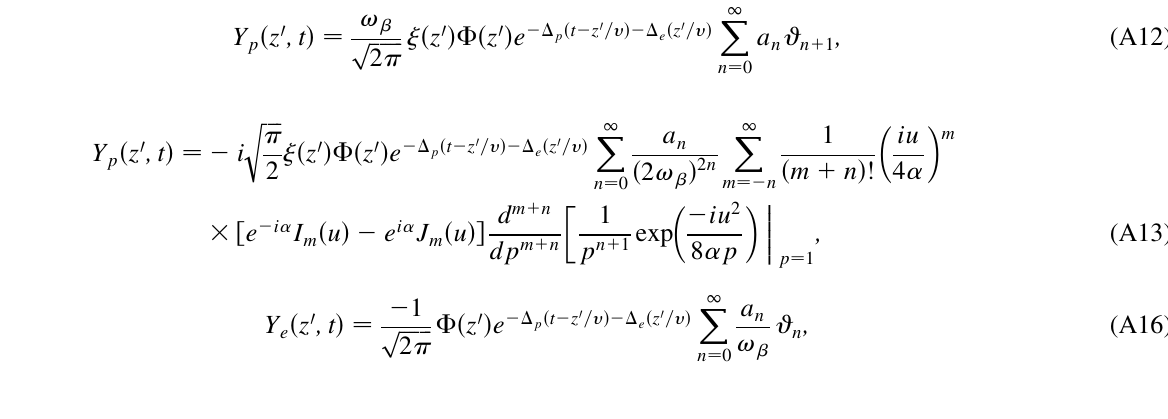
FIG. 5. The growing portion of the perturbed electron motion Y is computed using Eq. (58) with value of Y e long. The vertical axis has arbitrary